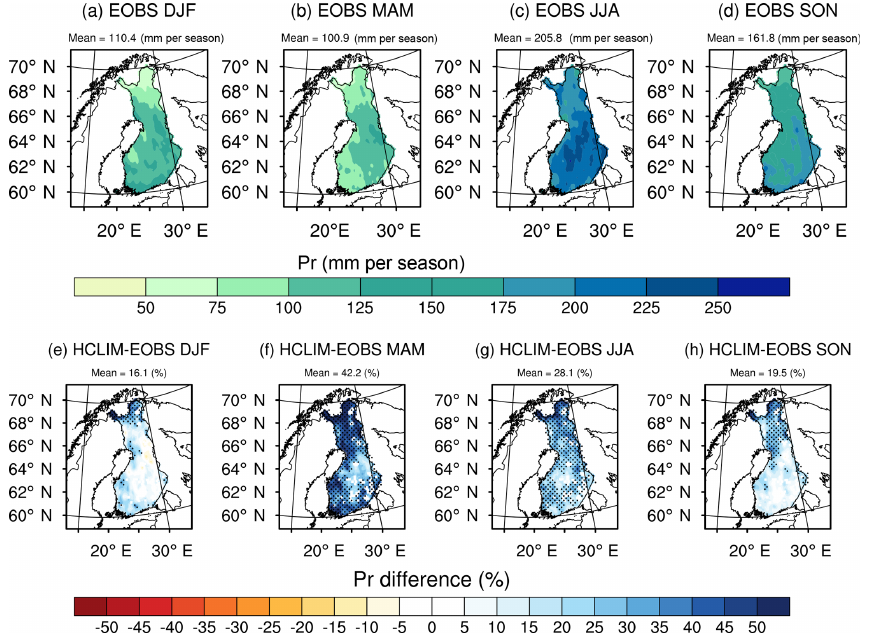
Figure 6. (a–d) The reference values of precipitation (Pr) from E-OBS data and (e–h) the biases of HCLIM38-ALARO modeled Pr with a reference to E-OBS. The seasonal averages were calculated for the time period of January 2002–December 2014. Stippled areas represent statistically significant differences with p values < 0 . 05.